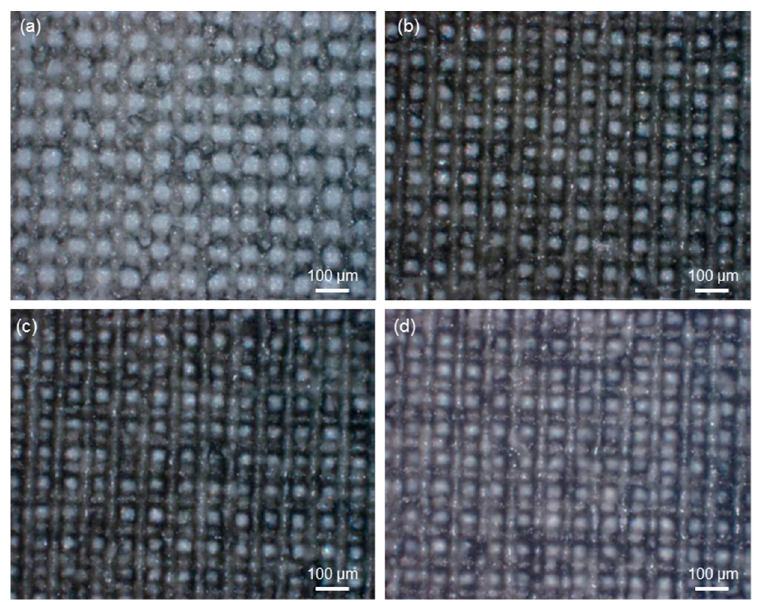
Figure 11. Optical micrographs showing the laser-treated surfaces ( Δα = 90°) of ( a ) sample 4a (number of cycles = 1), ( b ) sample 4b (number of cycles = 2), ( c ) sample 4c (number of cycles = 3), and ( d ) sample 4d (number of cycles = 4).